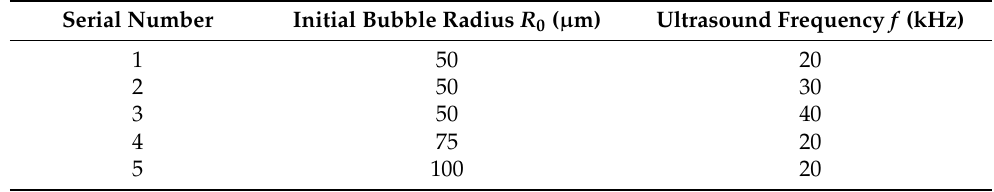
Table 1. Simulation conditions of ultrasonic cavitation near the wall.